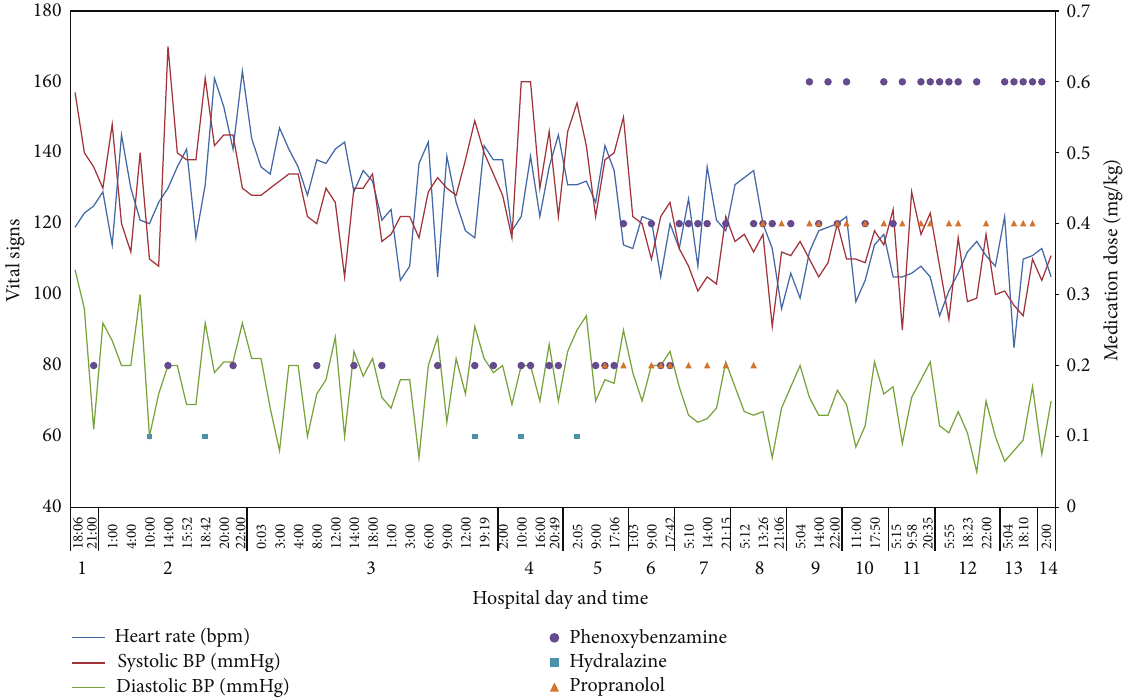
Figure 2: Sympathetic blockade and vital signs. Clinical data showing heart rate, systolic blood pressure, and diastolic blood pressure from admission until the time of tumor resection. Also shown are anticatecholamine medications and their doses over time. Note the progressive decreases in hypertension and tachycardia over the patient’s hospital course.